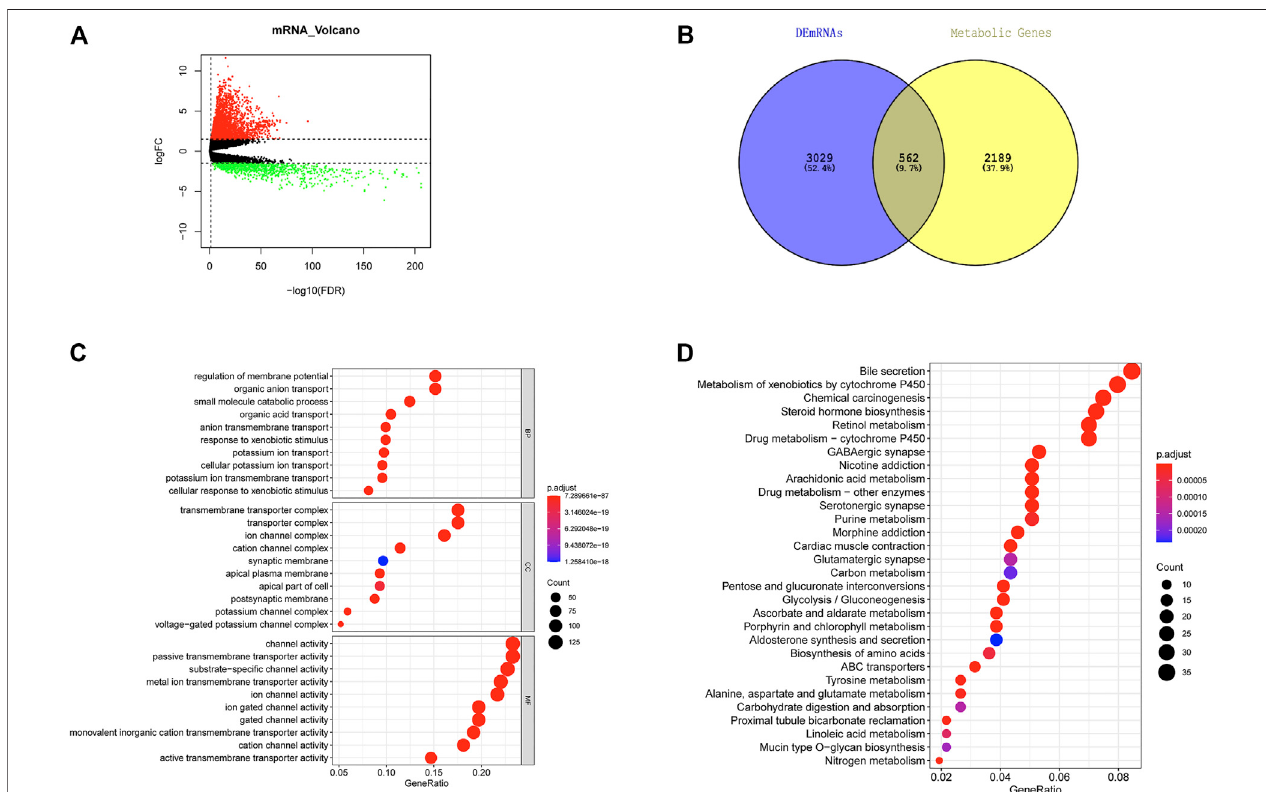
FIGURE 1 | Screening of metabolism-associated DEGs in LUAD and functional enrichment analysis. (A) Volcano plot of differential expression analysis on tumor groupandnormalgroupsinTCGA-LUADdataset.Red:signi fi cantlyupregulatedDEGs.Green:signi fi cantlydownregulatedDEGs. (B) OverlapofDEGsandmetabolism- associated genes in LUAD to acquire metabolism-associated DEGs in LUAD. (C) Bubble diagram of GO enrichment analysis on DEGs associated with metabolism in LUAD. Nodes: enriched terms. The node size is proportional to the number of enriched genes; the deeper red color of node indicates the smaller p values. (D) Bubble diagram of KEGG enrichment analysis on DEGs associated with metabolism in LUAD. Nodes: enriched terms. The node size is proportional to the number of enriched genes; the deeper red color of node indicates the smaller p values.